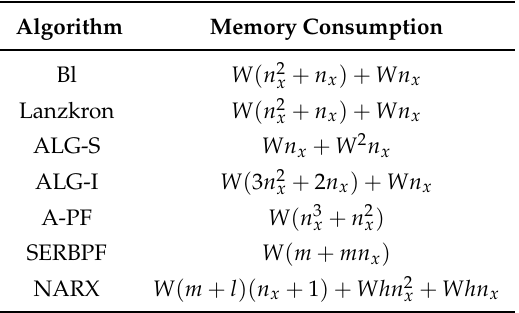
Table 2. Memory consumption of OOSM algorithms: W is the recursive time number, and n x is the element